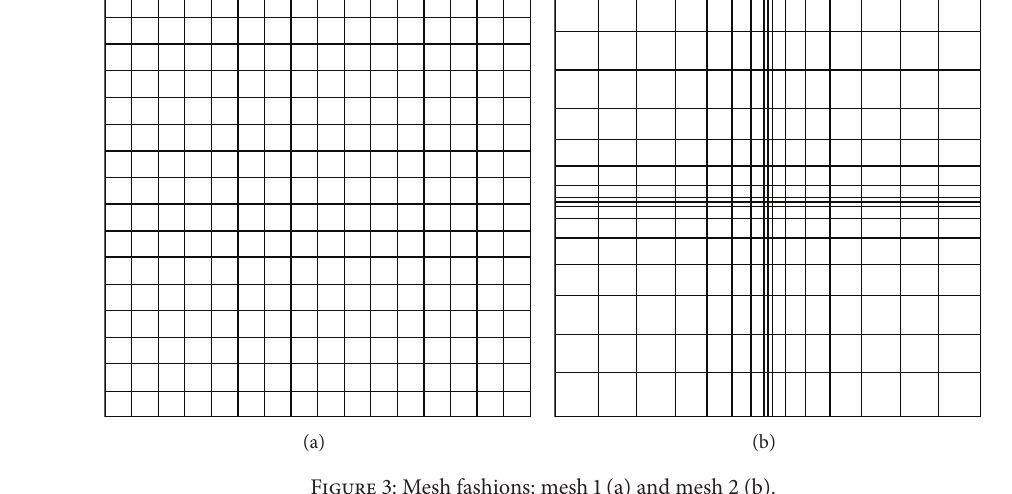
Figure 3: Mesh fashions: mesh 1 (a) and mesh 2 (b).